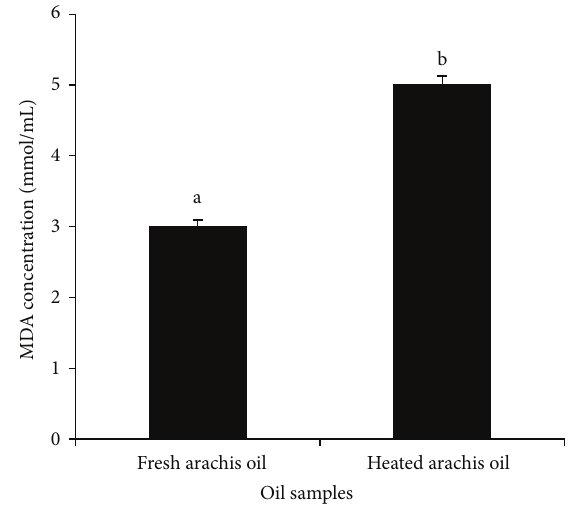
Figure6:EffectofthermaloxidationontheMDAcontentofarachis oil. MDA contents are expressed as mean ± standard deviation ( 𝑛 = 3 ). Bars with different alphabets are significantly different ( 𝑃 < 0.05 ).